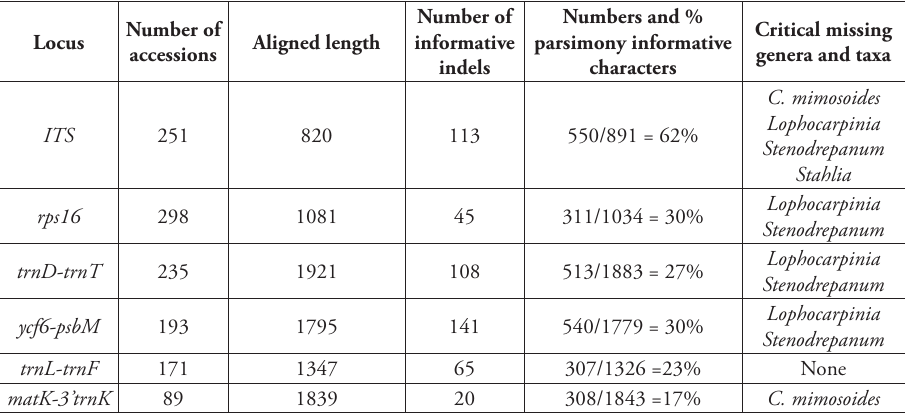
Table 1. Character statistics for the six loci analysed, with the number of accessions for each locus, aligned length (including ambiguous alignment regions), number of indels scored, numbers and % of par- simony informative characters (for both DNA and indel characters), and critical missing genera and taxa.